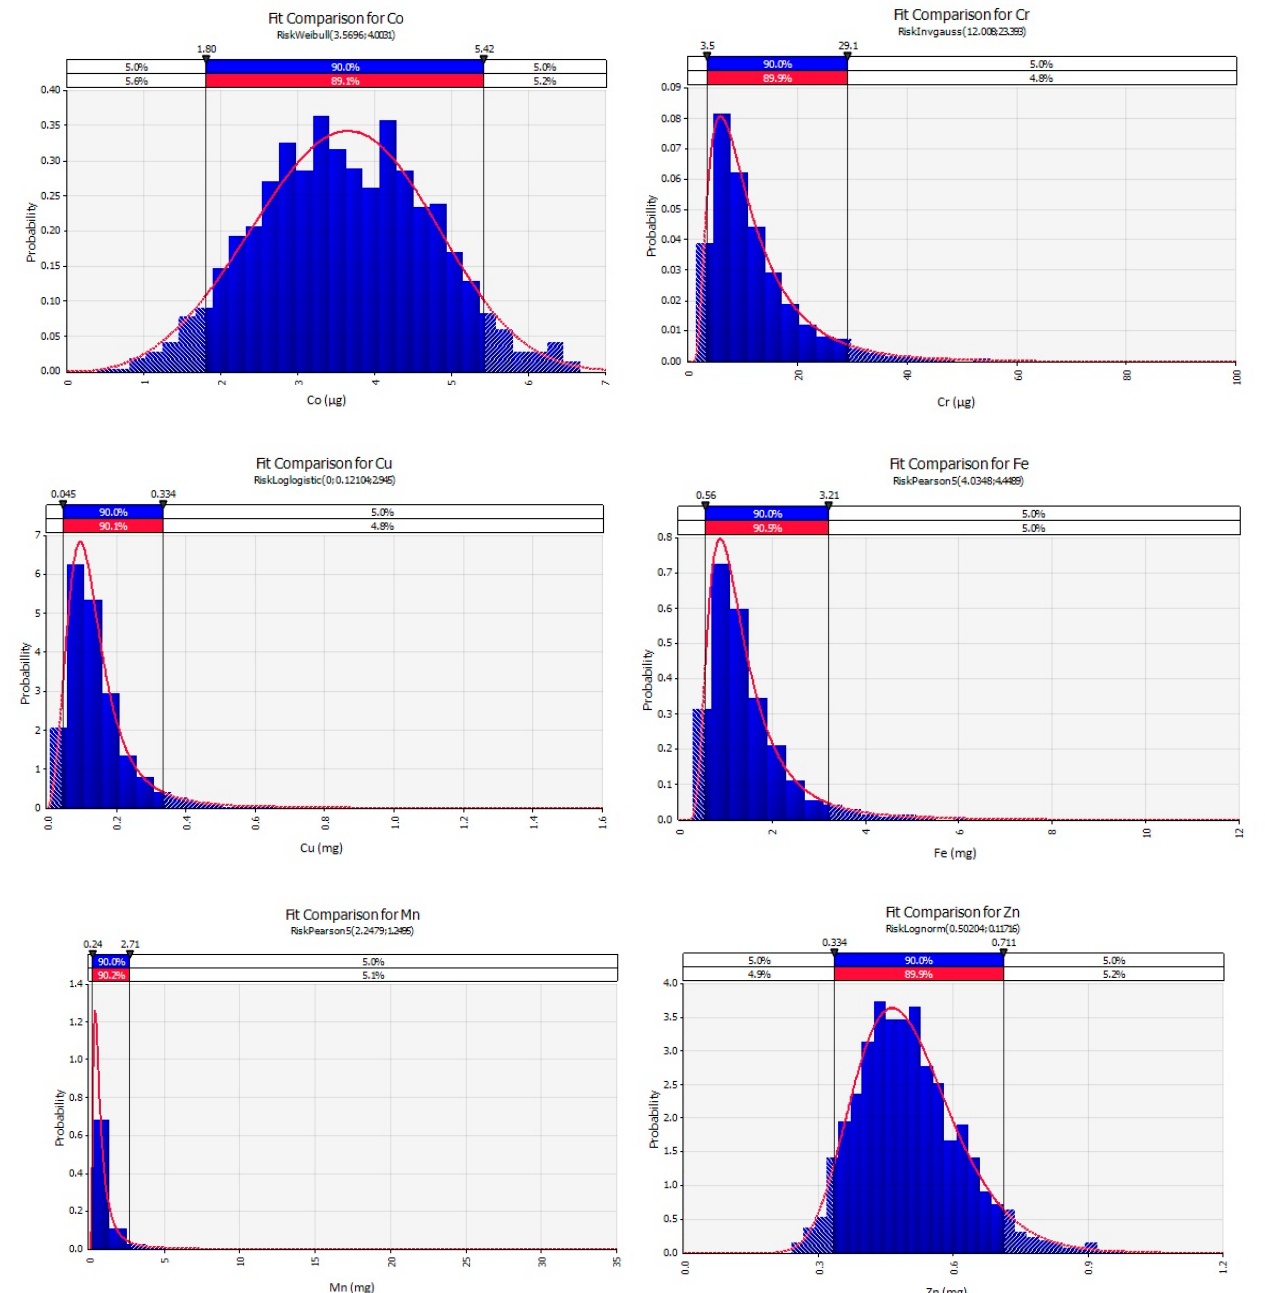
Figure 3. Simulated data and fitted probabilistic distribution for Co, Cr, Cu, Fe, Mn and Zn in organic Brassicas.